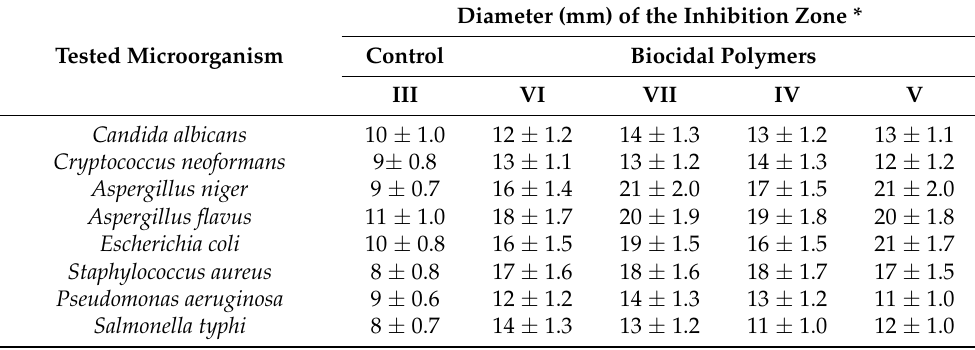
Table 3. Inhibition zone diameters (mm) for quaternized salts of